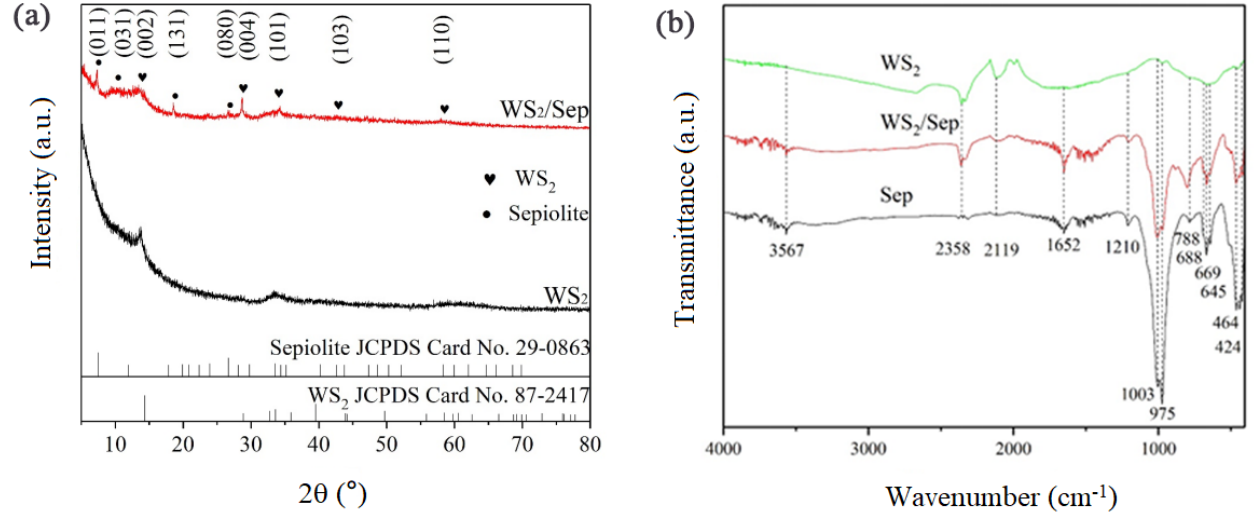
Figure 1. ( a ) XRD patterns of the pure WS 2 and WS 2 /Sep nanocomposites obtained via solvothermal at 220 °C ( b ) and FT-IR spectra of the pure WS 2 , sepiolite, and WS 2 /Sep nanocomposites.